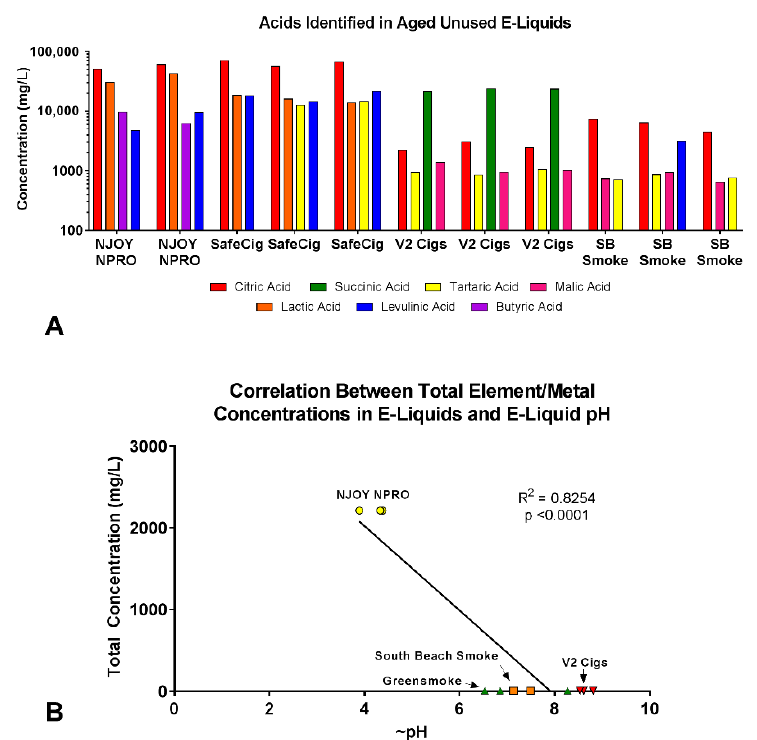
Figure 4. pH and acids in aged unused e-liquids. ( A ) Concentrations (mg/L) of acids measured in aged unused e-liquids. ( B ). Correlation graph showing relationship between total element/metal concentrations (mg/L) in the e-liquid and pH of the e-liquid.